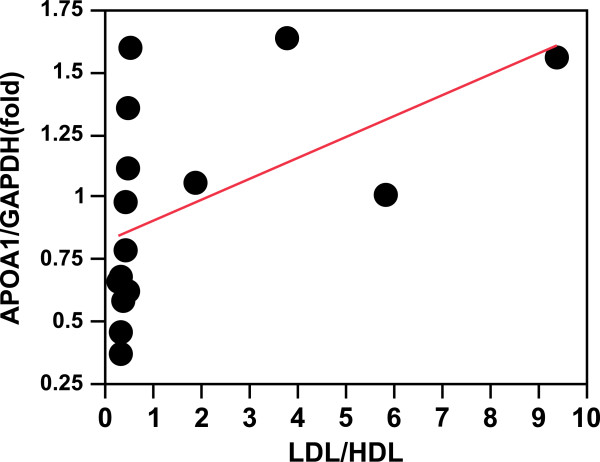
APOA1expression in RES liver relative to LDL/HDL ratio. r2 = 0.28; P < 0.04.